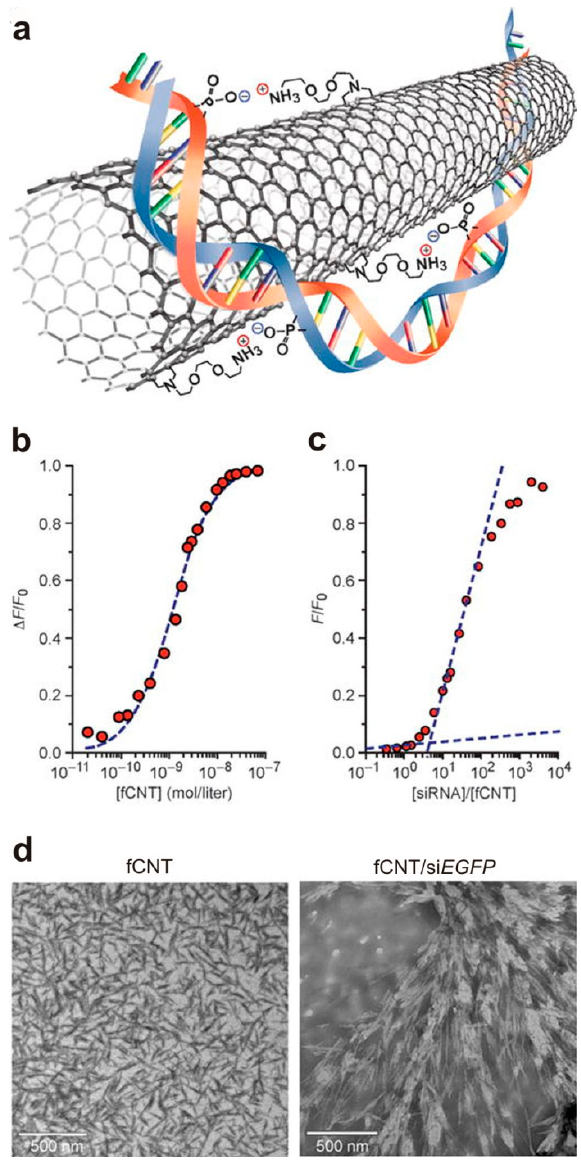
Figure 2. Assembly of the CNT siRNA structure: ( a ) A representation of the noncovalent bonding interactions between siRNA and fCNT; ( b ) The fluorescence quenching titration of siEGFP-Cy3 with fCNT and fitted binding isotherm (dashed line); ( c ) Relative fluorescence intensity as a function of siEGFP-Cy3/fCNT molar ratio and graphical interpolation of the curve; ( d ) TEM images of solid-state fCNT and fCNT/siEGFP (1:1 complex). Reproduced with permission [87]. Copyright 2016, American Association for the Advancement of Science.